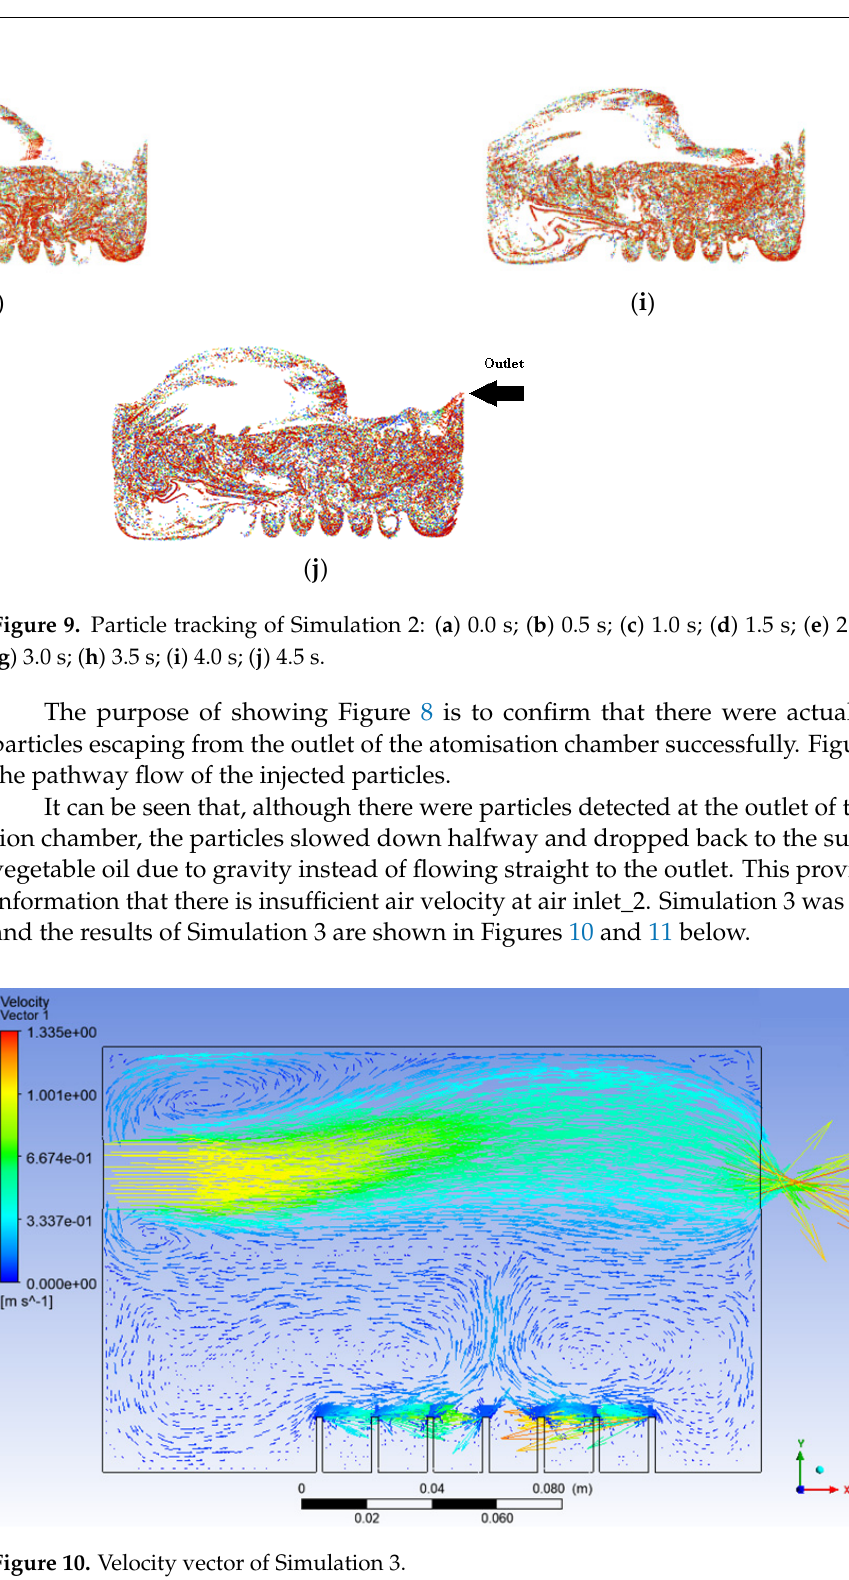
Figure 10. Velocity vector of Simulation 3.